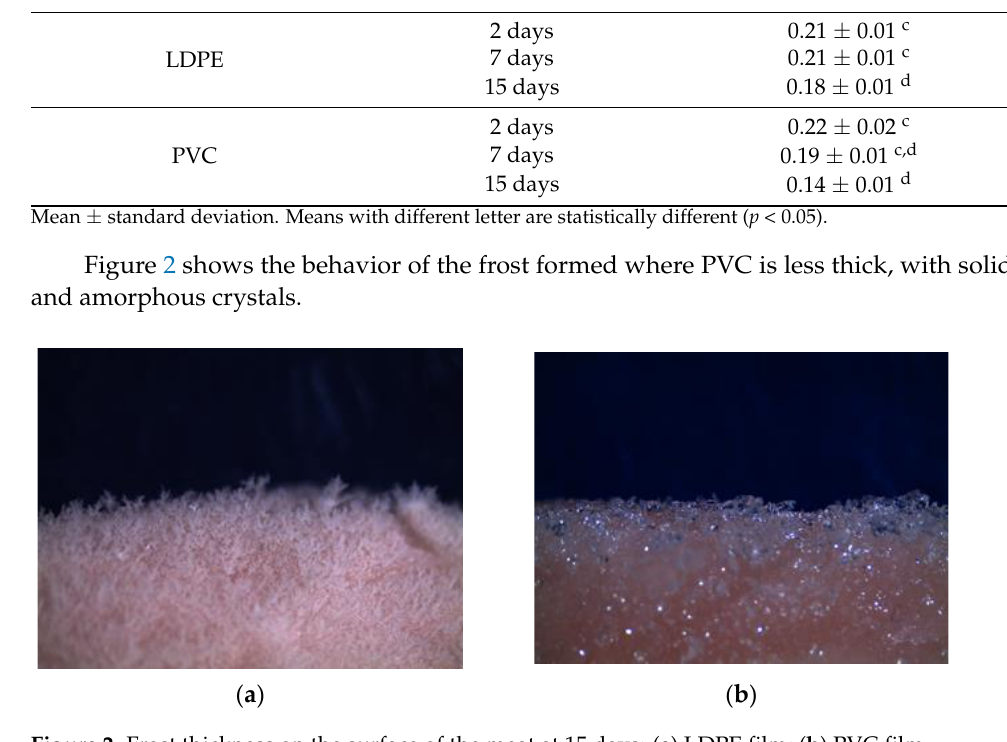
Figure 2. Frost thickness on the surface of the meat at 15 days: ( a ) LDPE film; ( b ) PVC film.